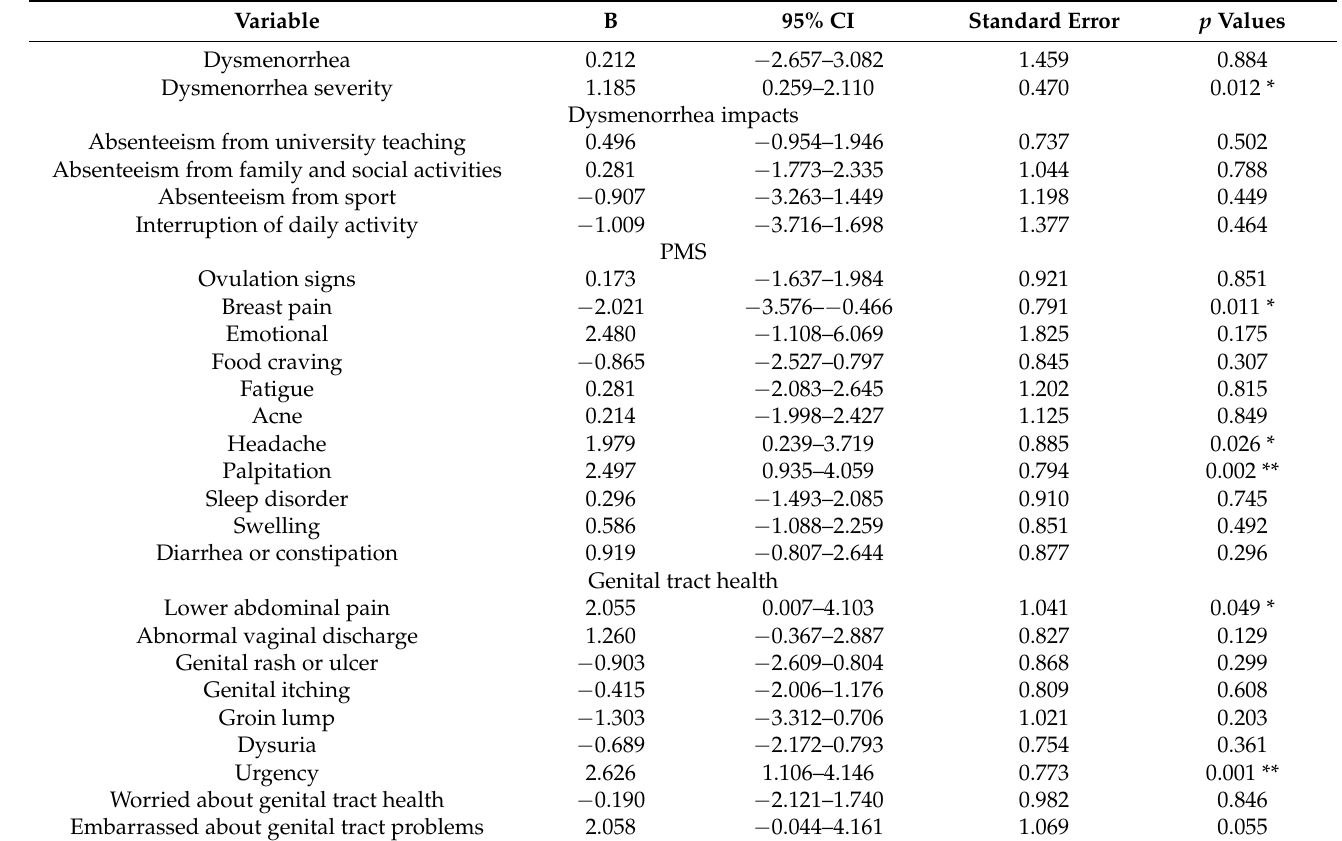
Table 7. Associations between dysmenorrhea, PMS, and genitourinary symptoms with stress scores using multiple linear regression